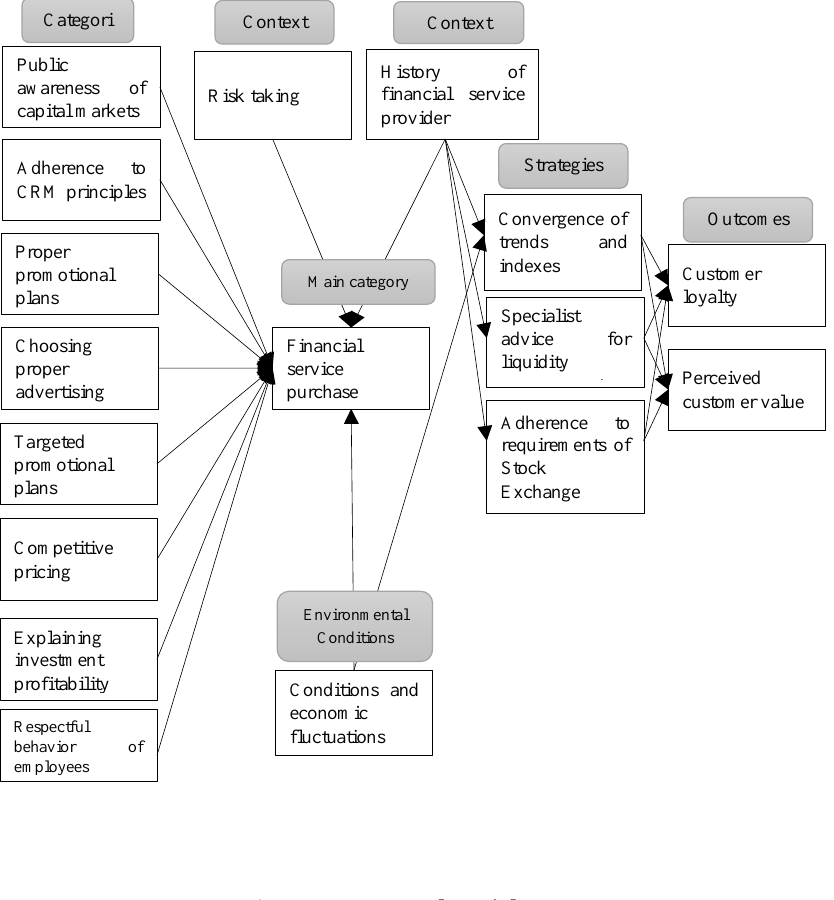
Figure 3.Conceptual